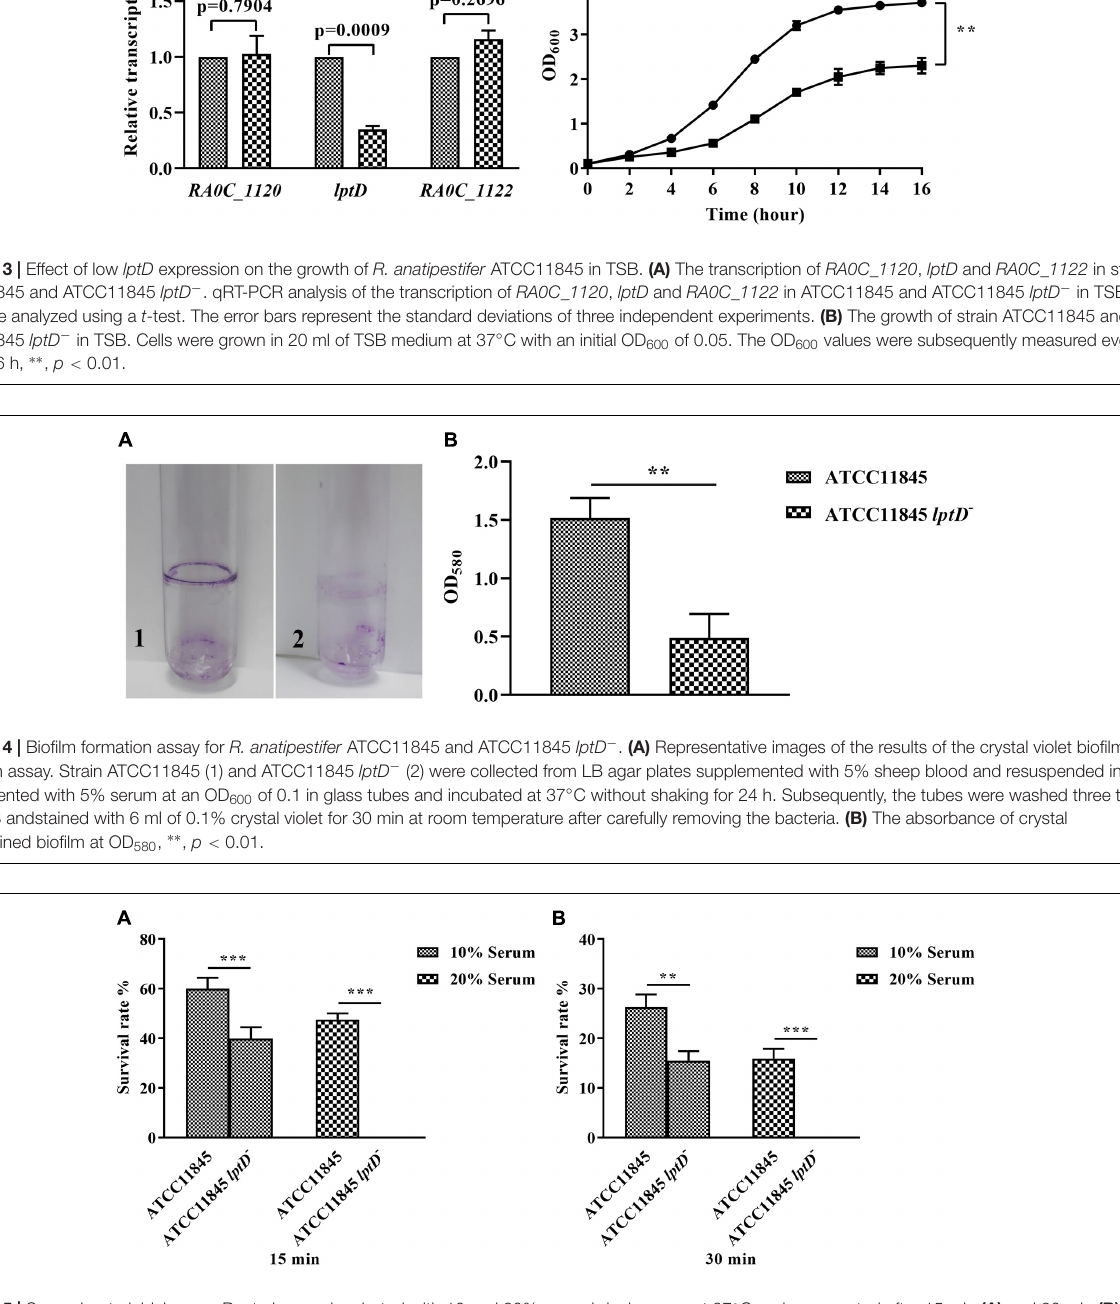
FIGURE 5 | Serum bactericidal assay. Bacteria were incubated with 10 and 20% normal duck serum at 37 ◦ C and enumerated after 15 min (A) and 30 min (B) of incubation. The resistance of strain ATCC11845 lptD − to duck serum was significantly reduced compared with that of strain ATCC11845 ( ∗∗ , p < 0.01, ∗∗∗ , p < 0.001).The survival rate (%) was calculated as follows: (bacterial CFU with serum treatment/bacterial CFU with PBS treatment) ×